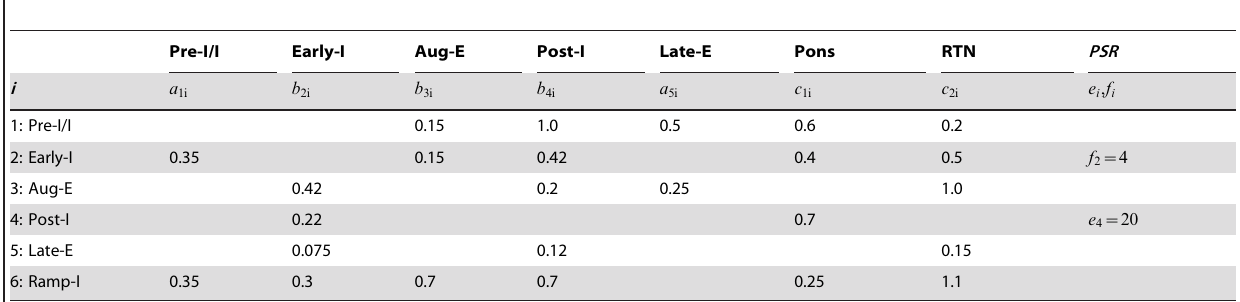
Table 1. Parameters of neural